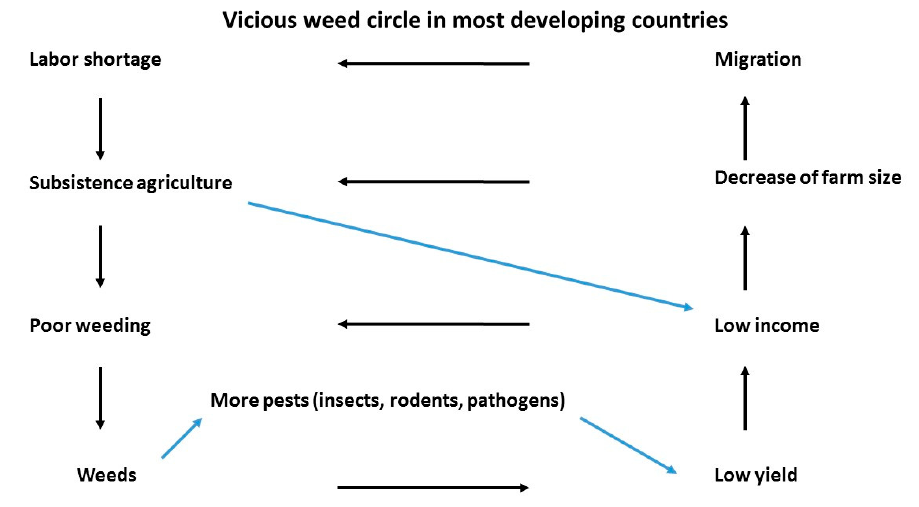
Figure 1. The vicious weed cycle that can affect smallholder farmers’ crop yields in developing countries. (Adapted from [56]).